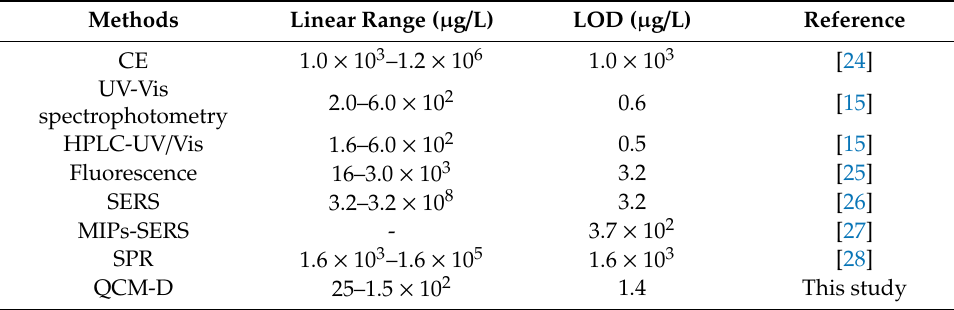
Table 4. Comparison of the method with other methods for detecting methylene